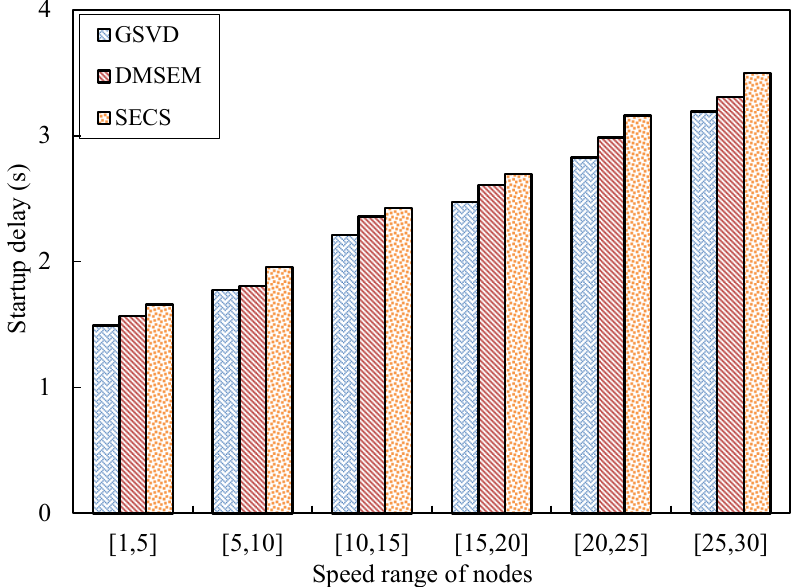
Figure 4. Startup delay against the various speed ranges of the